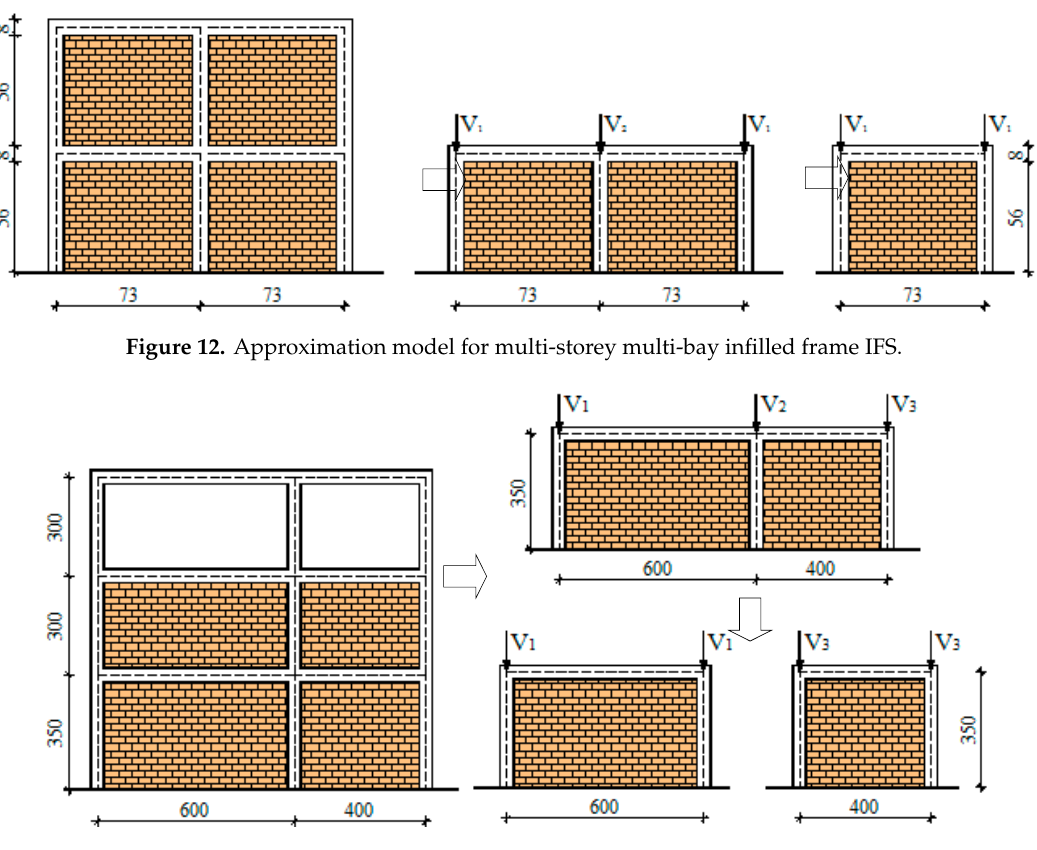
Figure 14. Approximation model for multi-storey multi-bay infilled frame EC8. Neural network processing is done on previously trained neural networks with new input data from Table 12, calculated according to the loads from Table 13. Table 12. Input data for neural network processing. Buildings